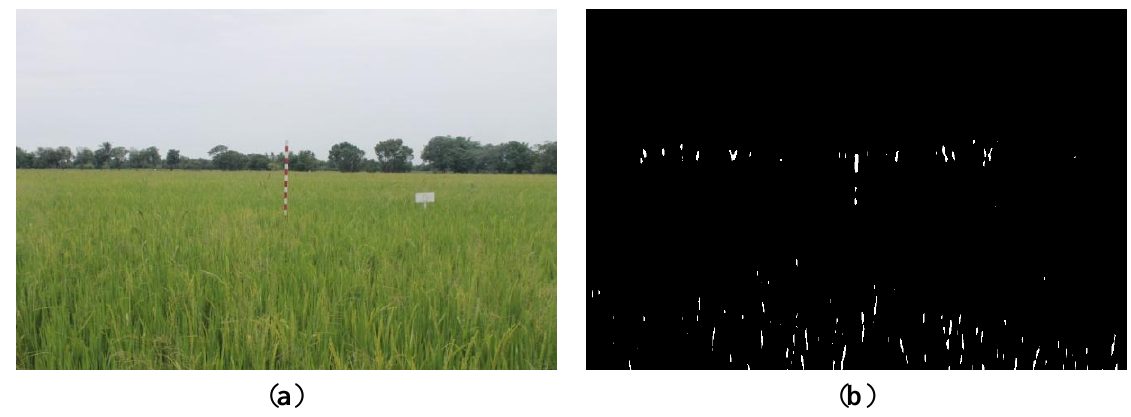
method with red band feature on 18 July 2012.